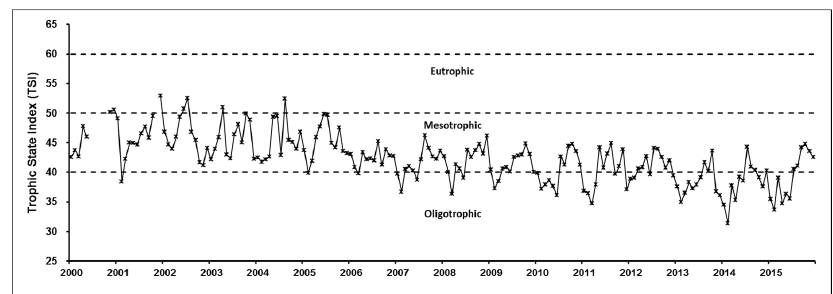
Figure 3. Time series of TSI in the water surface of Fei-Tsui Reservoir from 2000 to 2015.